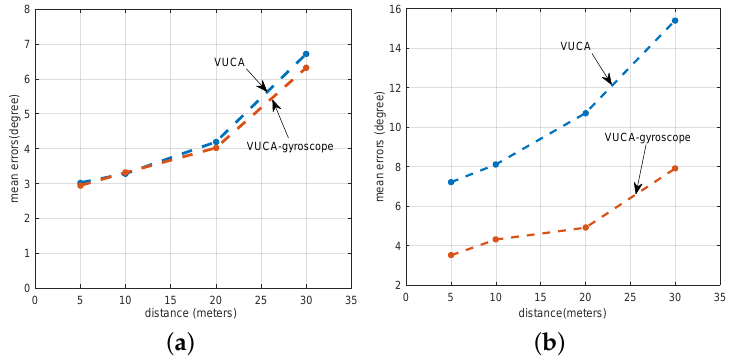
Figure 13. ( a ) mean errors of the VUCA system and the VUCA-gyroscope system with different distance and stable motion patterns; and ( b ) mean errors of the VUCA system and the VUCA-gyroscope system with different distance and unstable motion